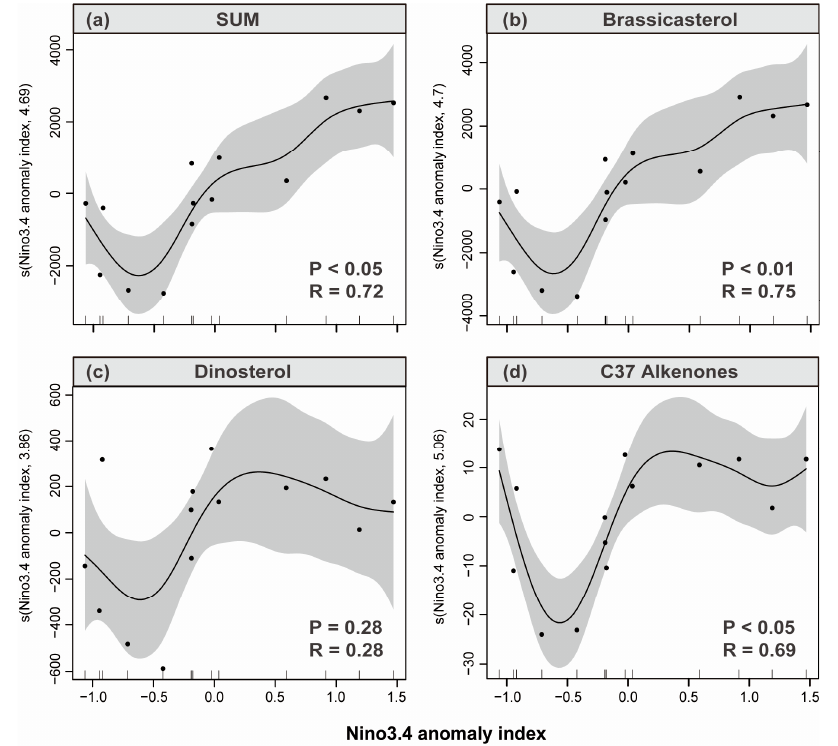
Figure 5. Fit of different plankton biomarker concentration and Niño 3.4 index anomaly from 1822 to 2015 (gray, 95% confidence